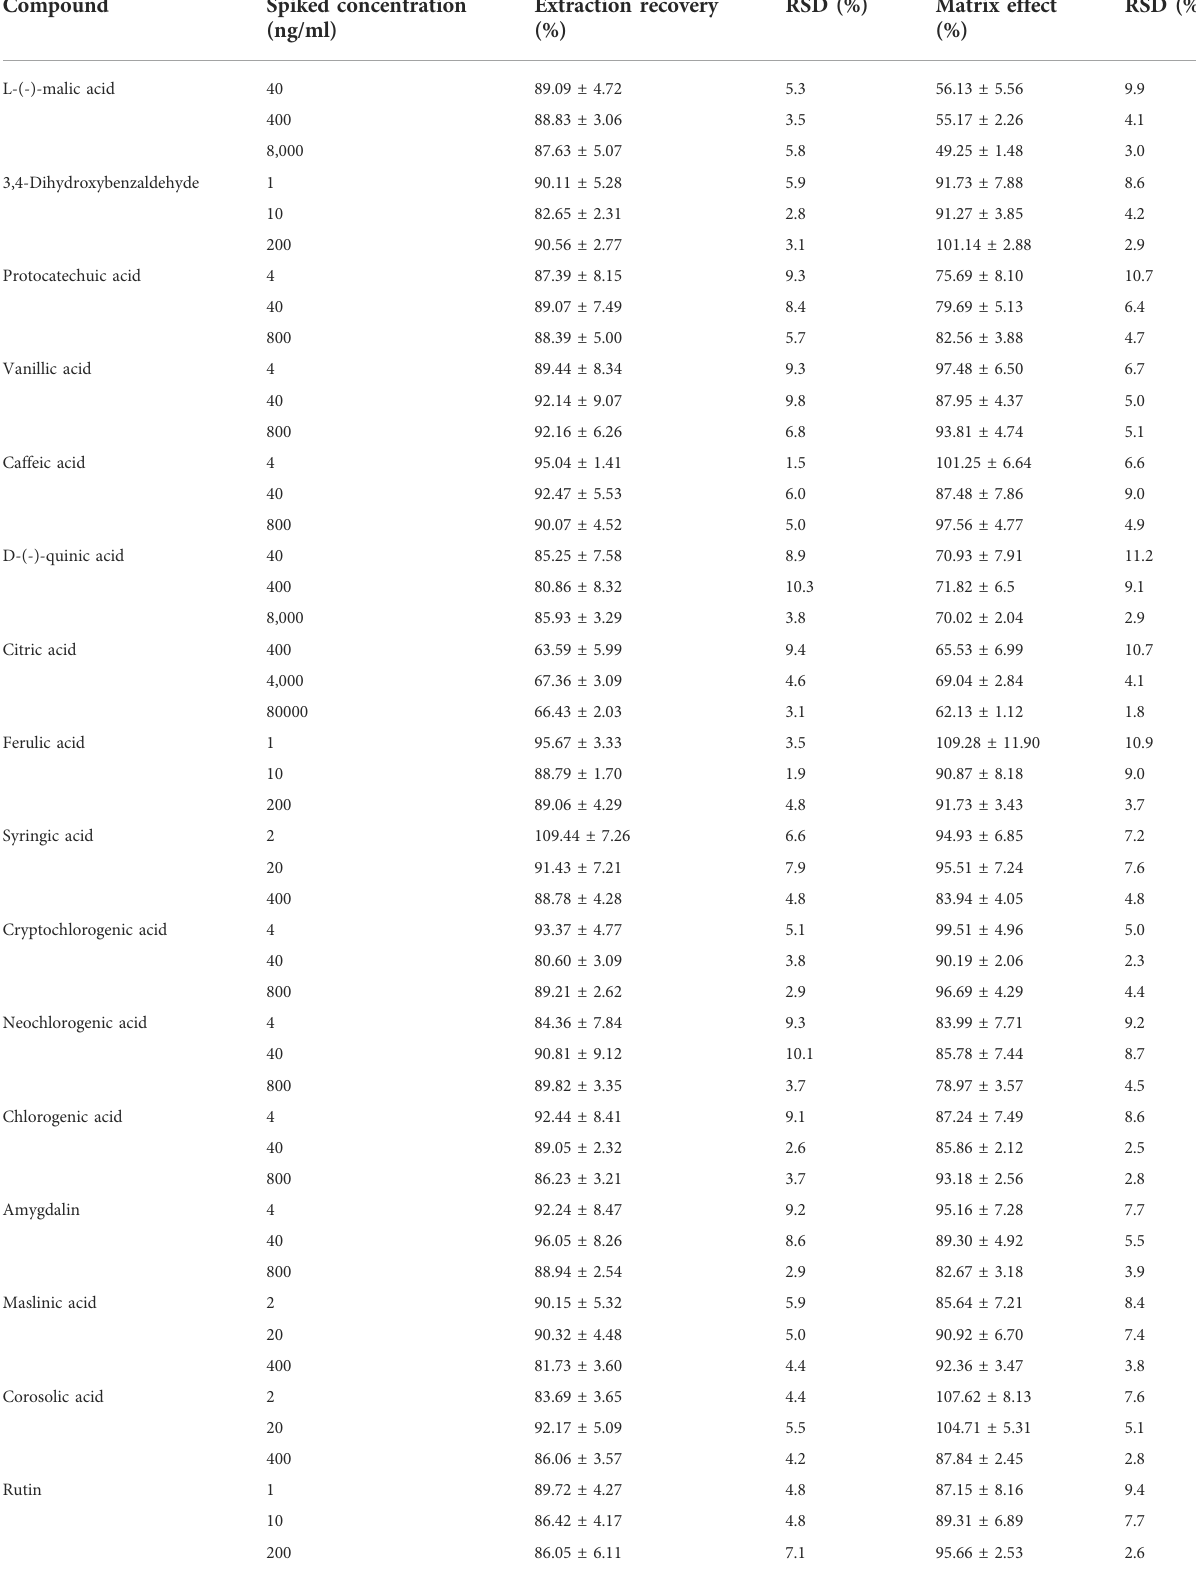
TABLE 3 Extraction recovery and matrix effects of 16 analytes in rat plasma ( n = 6).